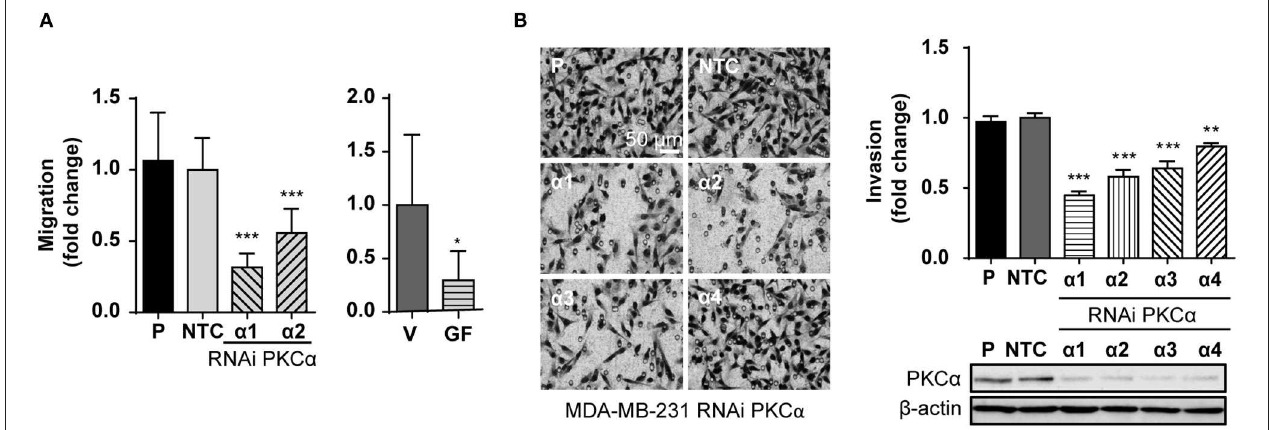
FIGURE 4 | PKC α silencing recapitulates the EMT phenotypes associated with ZEB1 downregulation. (A) MDA-MB-231 cells were transfected with specific PKC α RNAi duplexes ( α 1 and α 2) or NTC RNAi for 72h or treated with GF109203X ( GF , 5 µ M) for 48h. Migration was assessed using a wound healing assay. Graphics represent the migrated area relativized to NTC or vehicle (V), respectively. (B) MDA-MB-231 cells were transfected with four different PKC α RNAi duplexes ( α 1, α 2, α 3, and α 4) or NTC RNAi, and invasion was assessed 72h later. The images display representative fields of invading cells. Bar: 50 µ m. Graphs show the percentage of invading cells per field relativized to the NTC. Results are expressed as mean ± S.D. * p ≤ 0.05; ** p ≤ 0.01; *** p ≤